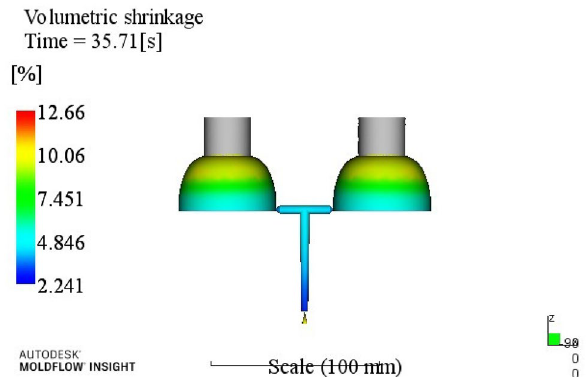
Figure 5. Volume shrinkage after optimization.